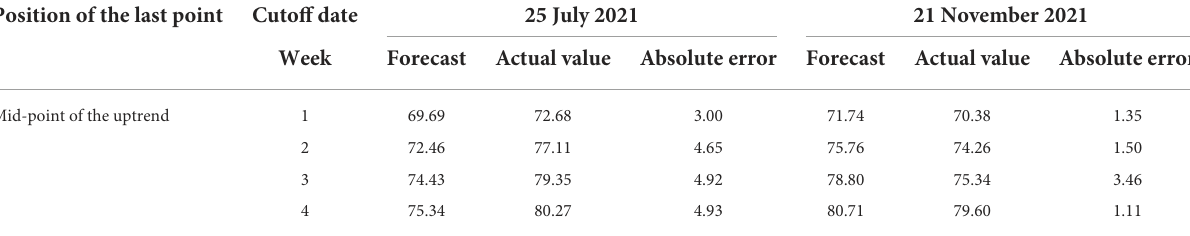
TABLE 5 Forecast result when the last point is at the midpoint of the upward trend. Position of the last point